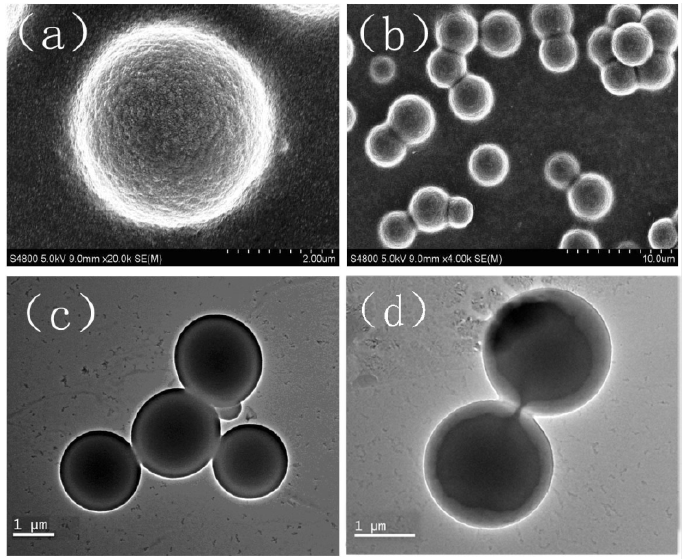
Figure 2. SEM ( a and b ) and TEM ( c and d ) images of the DPG particles.